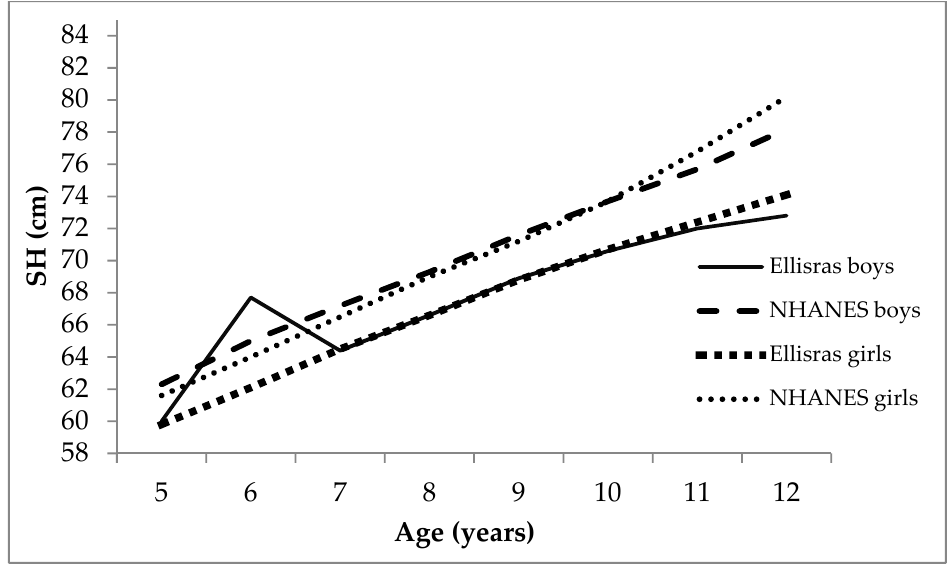
Figure 1. The comparison of SH in Ellisras and National Health and Nutrition Examination Survey (NHANES) children aged 5–12 years.